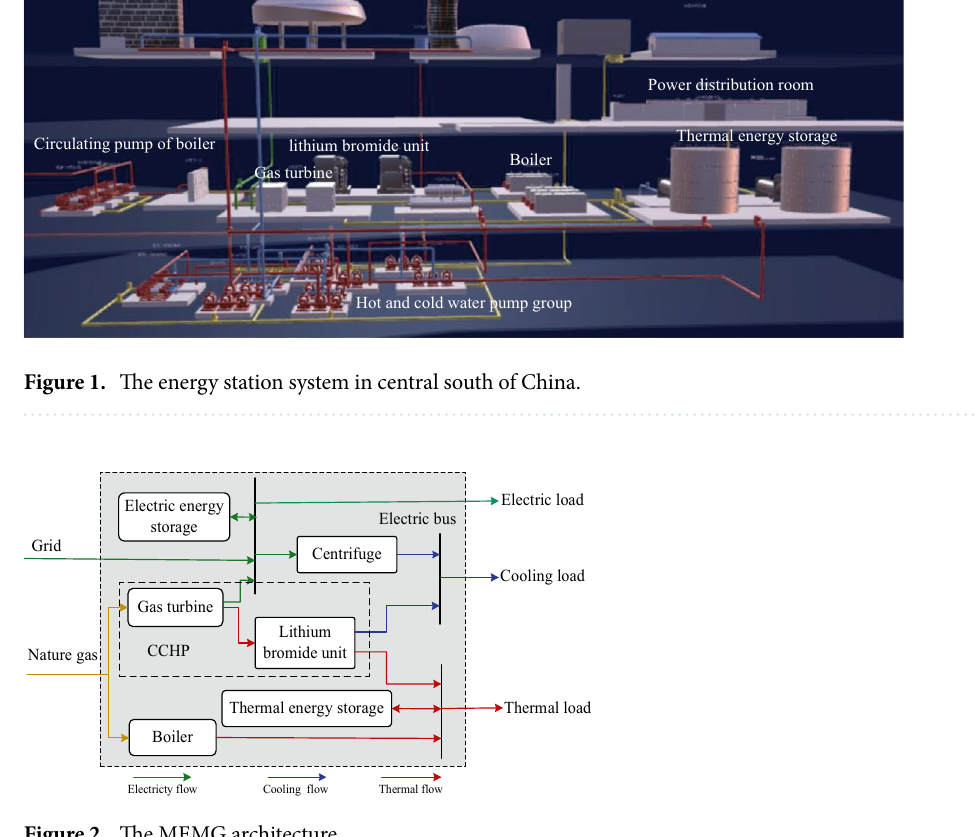
Figure 2. The MEMG